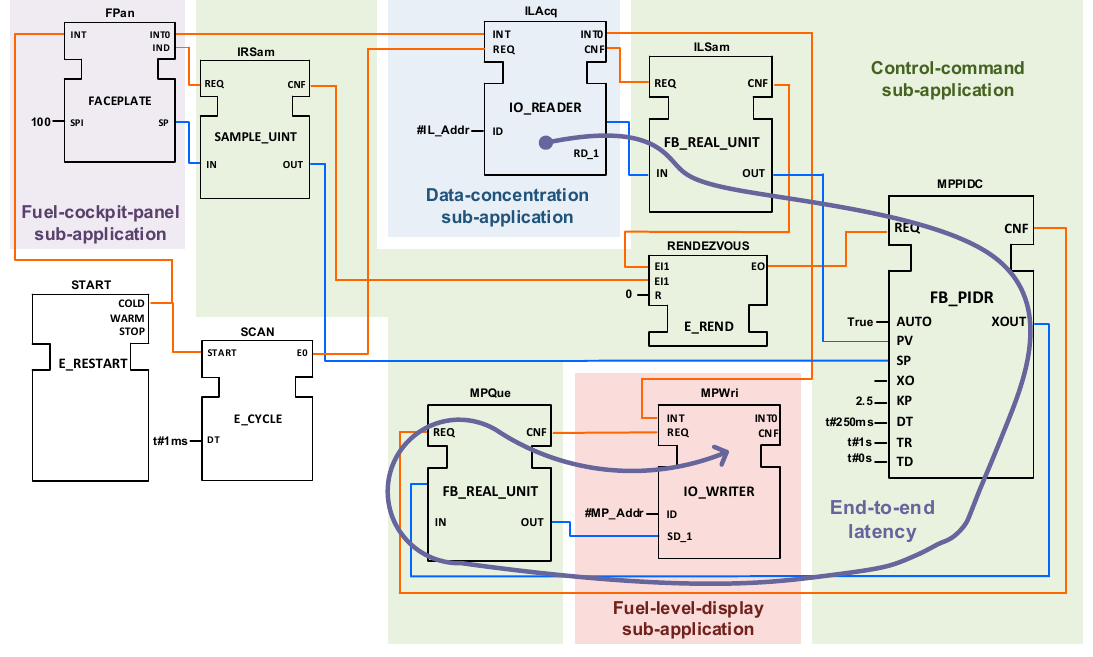
Figure A1. Main FMMS application.